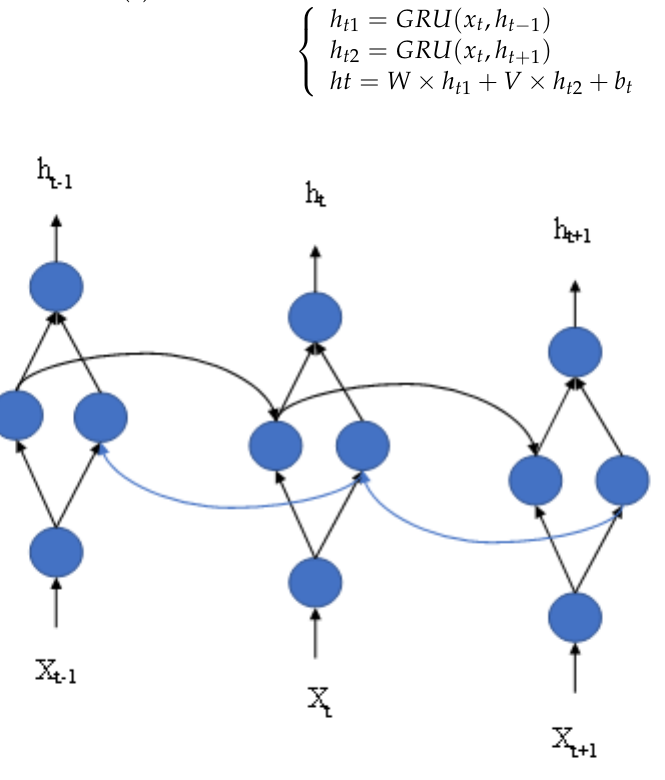
Figure 3. The BiGRU structure diagram.